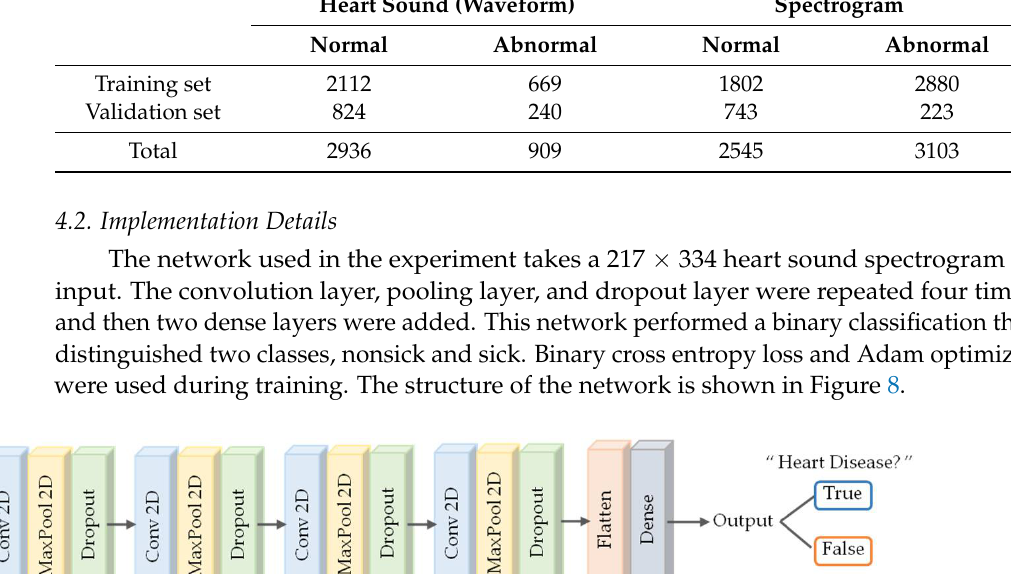
Figure 7. Abnormal train data augmentation. ( a ) Normal, ( b ) random noise, ( c ) left shift, ( d ) x-axis symmetry, ( e ) mask- ing, ( f ) s&p noise.